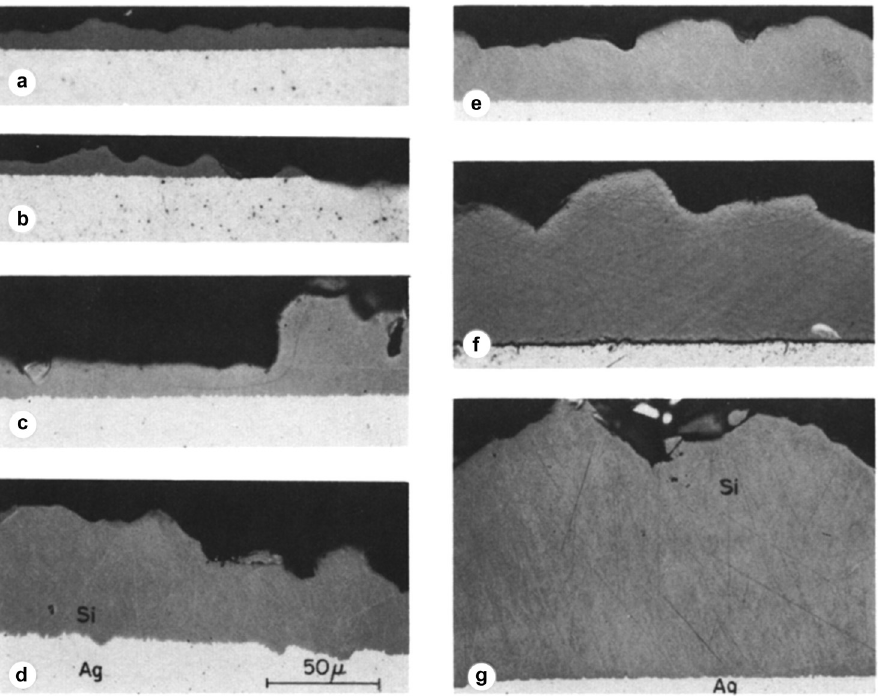
Figure 4: Cross - sectional SEM images of electrodeposited Si onto Ag substrates prepared at 25mA · cm − 2 in molten LiF – KF containing 12mol% K 2 SiF 6 at 1,023 K for ( a ) 1h, ( b ) 1.5h, ( c ) 2 h, ( d ) 3h, ( e ) 4h, ( f ) 6h, and ( g ) 8h [ 94 ] . Permission from Elsevier.